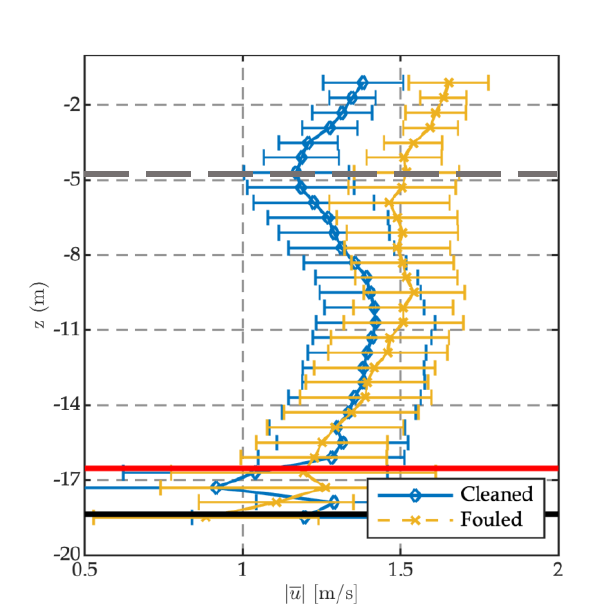
Fig. 14 Effect of fouling on the measured and BEM predicted turbine thrust as function of the inflow velocity in the wake of “fouled” rotors is less than “cleaned” tur- bines case, with a 0.3 m/s additional velocity decrease when turbines are fouled when the inflow velocity is about 2 m/s. This result is consistent with Fig. 14 and Fig. 15 as “fouled” rotors extract less energy from the flow hence a weaker wake would be expected.